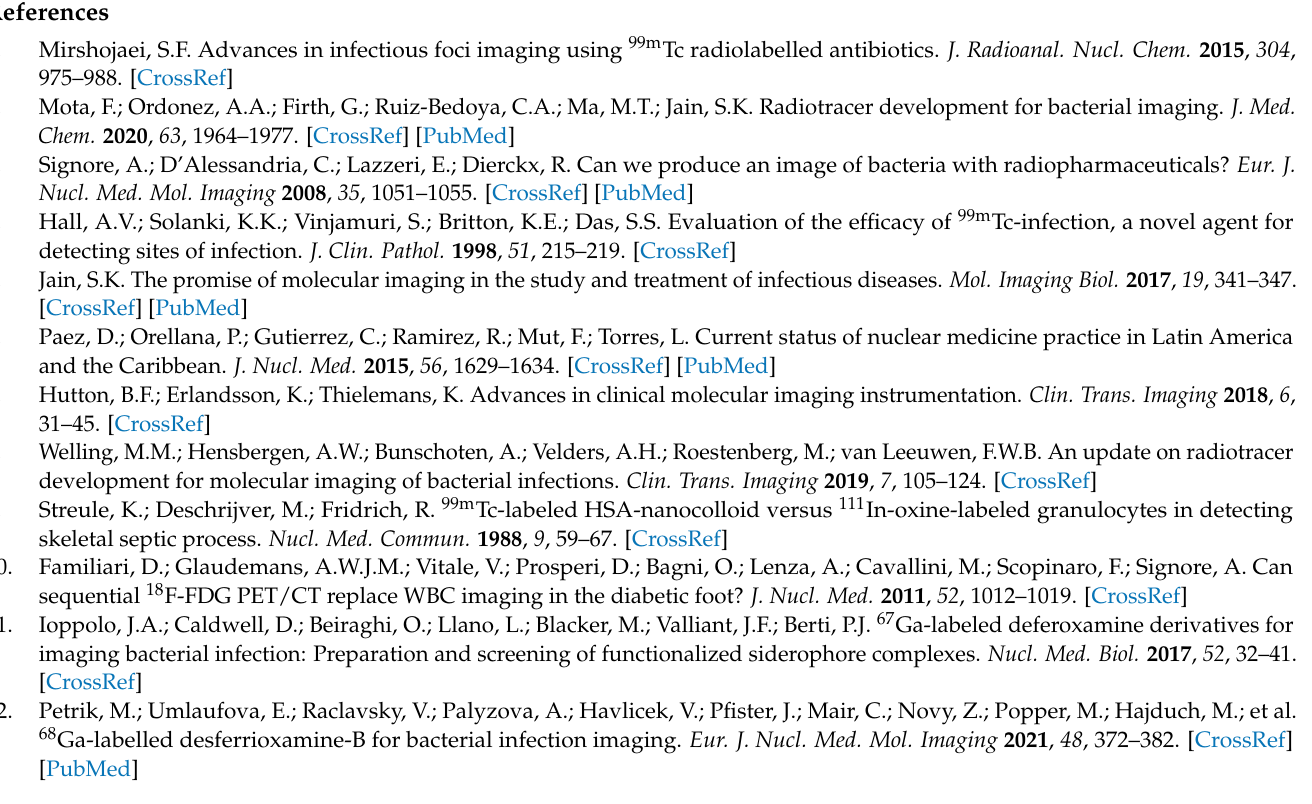
NMR spectrum of Compound 9 , Figure S2: 1 H NMR spectrum of Compound 10 , Figure S3: HR-MS spectrum of Compound 9 , Figure S4: HR-MS spectrum of Compound 10